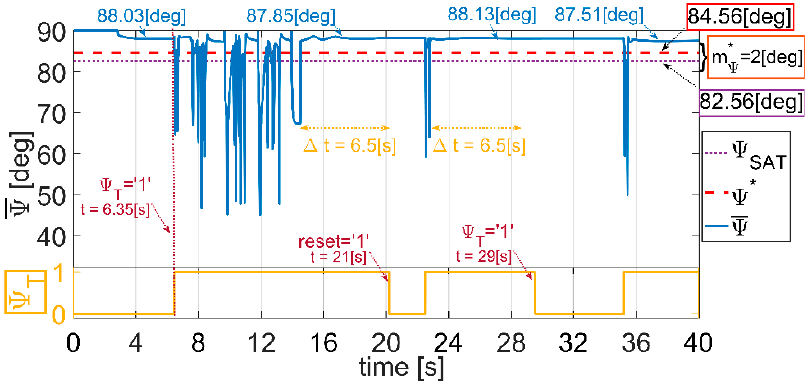
Figure 25. Bending on Low-Friction Patch: Pseudoinverse matrix Θ ( ij ,1 − 2 ) and IWM selectors ρ m .